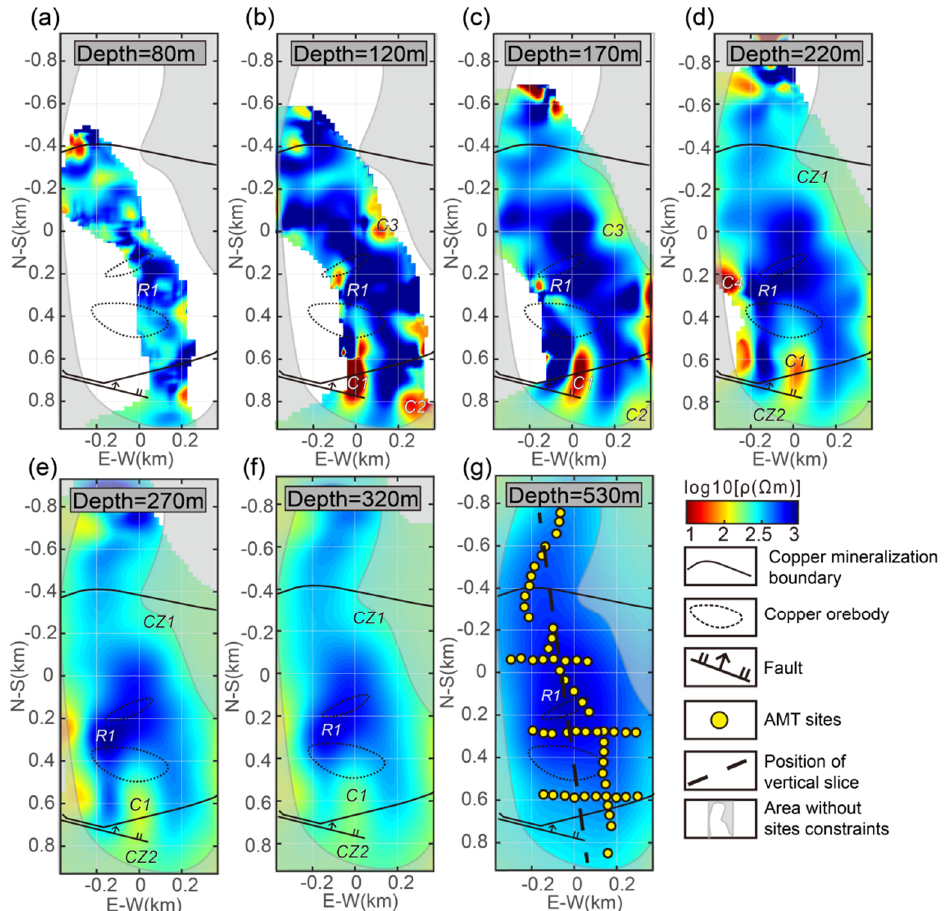
Figure 7. Horizontal slices of 3D inversion model at depths of 80, 120, 170, 220, 270, 320, 530 m ( a – g ), respectively. The pure white regions represent air at corresponding depths. The superposed geological features are the same as Figure 3b. Warm and cold colors indicate low and high resistivity, respectively. CZ1 and CZ2 indicate major conductive zones.